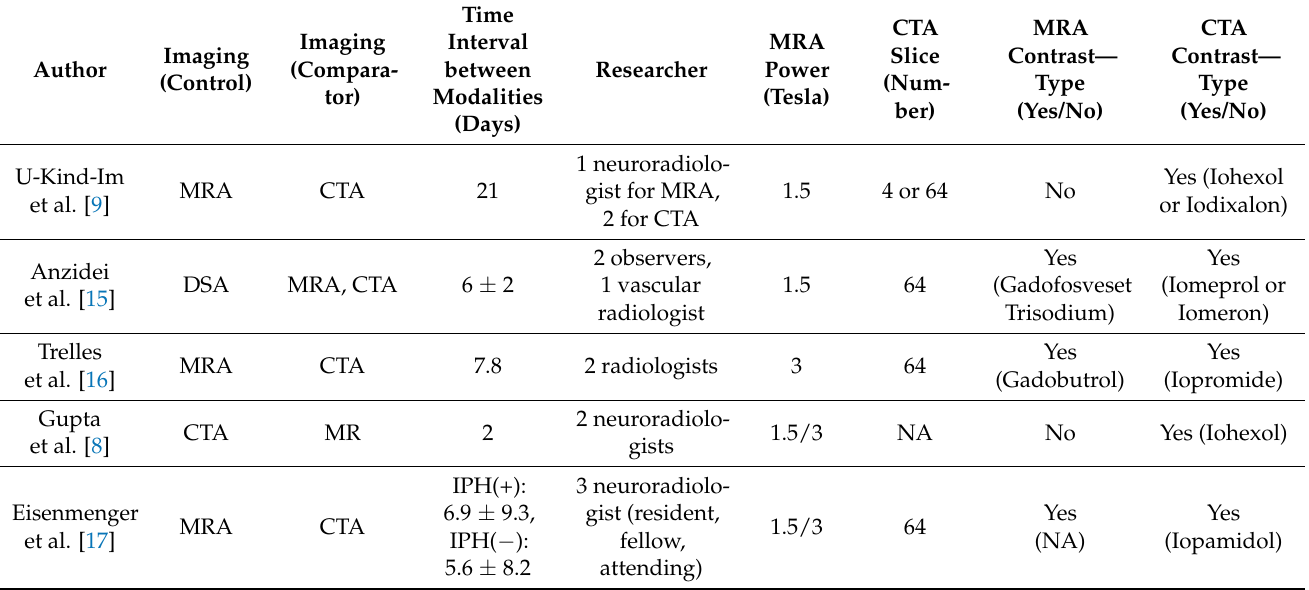
Table 3. The characteristics of the main imaging modalities (CTA, MRA), as reported in the in- cluded